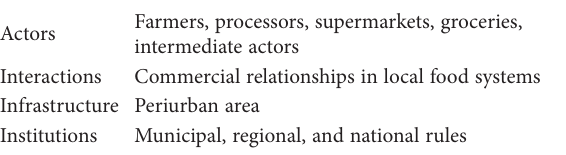
Table 1. The structures of systemic innovation in this study.